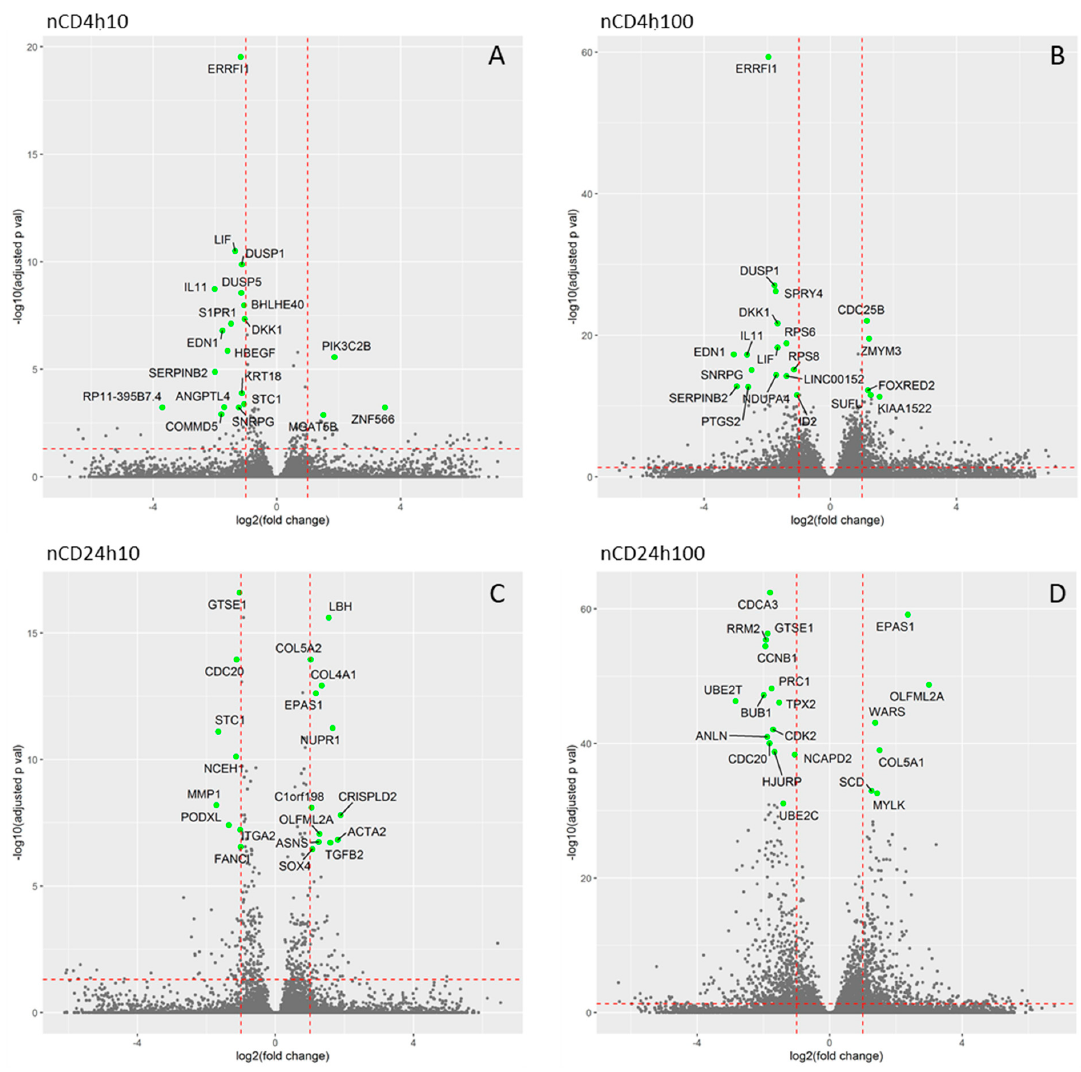
Figure 7. Volcano scatter-plots showing the relationship between significance and fold change of individual mRNA transcripts expression. The horizontal dashed red line highlights the adjusted p -value of 0.05, the vertical lines denote the fold changes equal of 0.5 and 2. In each plot the 20 most significant transcripts are identified. ( A )-nCD4h10, ( B )-nCD4h100, ( C )-nCD24h10, ( D )-pCD24h100.